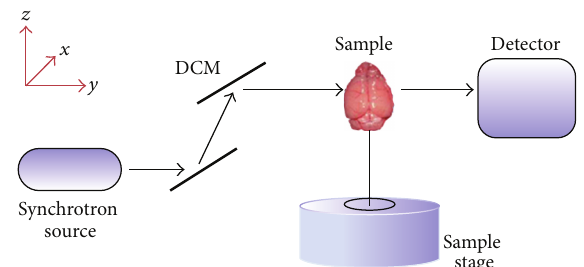
Figure 1: Schematic of the imaging system of SRXPCT. The monochromatic SR system at the BL13W1 beamline outputs 16KeV X-ray illuminating the brain sample. The sample was rotated on the samplestageforCTreconstruction.Imageswererecordedbyahigh- resolution CCD (pco. 2000, PCO AG, Kelheim, Germany) with 1: 2 microscopic lens and Yag:Ce